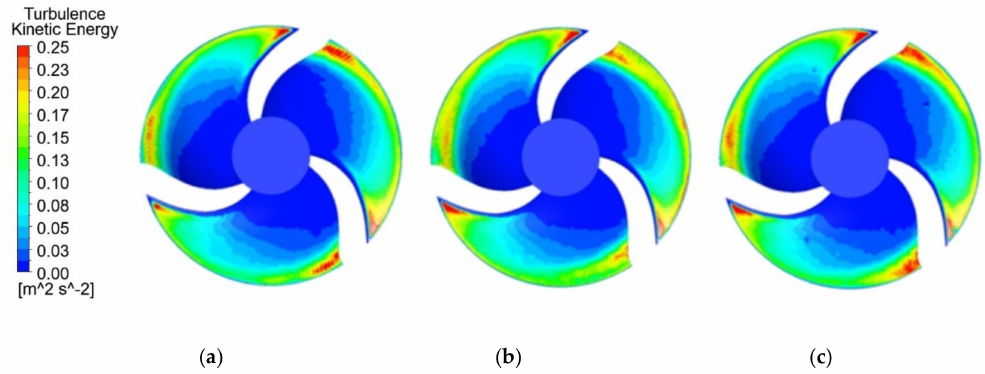
Figure 11. Distribution of turbulence kinetic energy on blades of different schemes: ( a ) Case-Basic, ( b ) Case-10, and ( c )